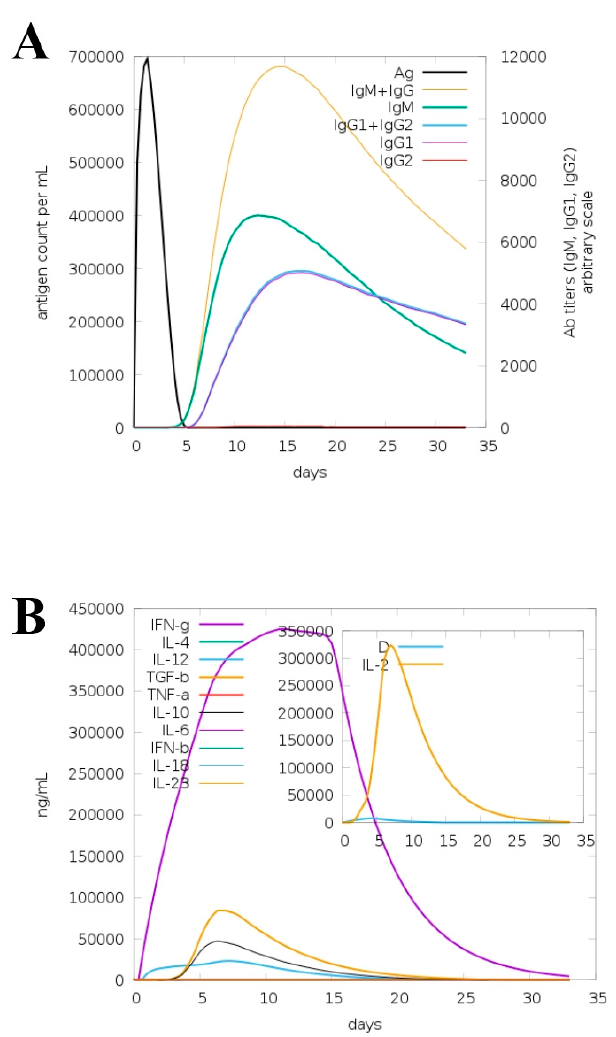
Figure 14. Host immune responses to the designed vaccine construct. Immunoglobulin responses to the vaccine ( A ); interferon and cytokine responses to the vaccine ( B